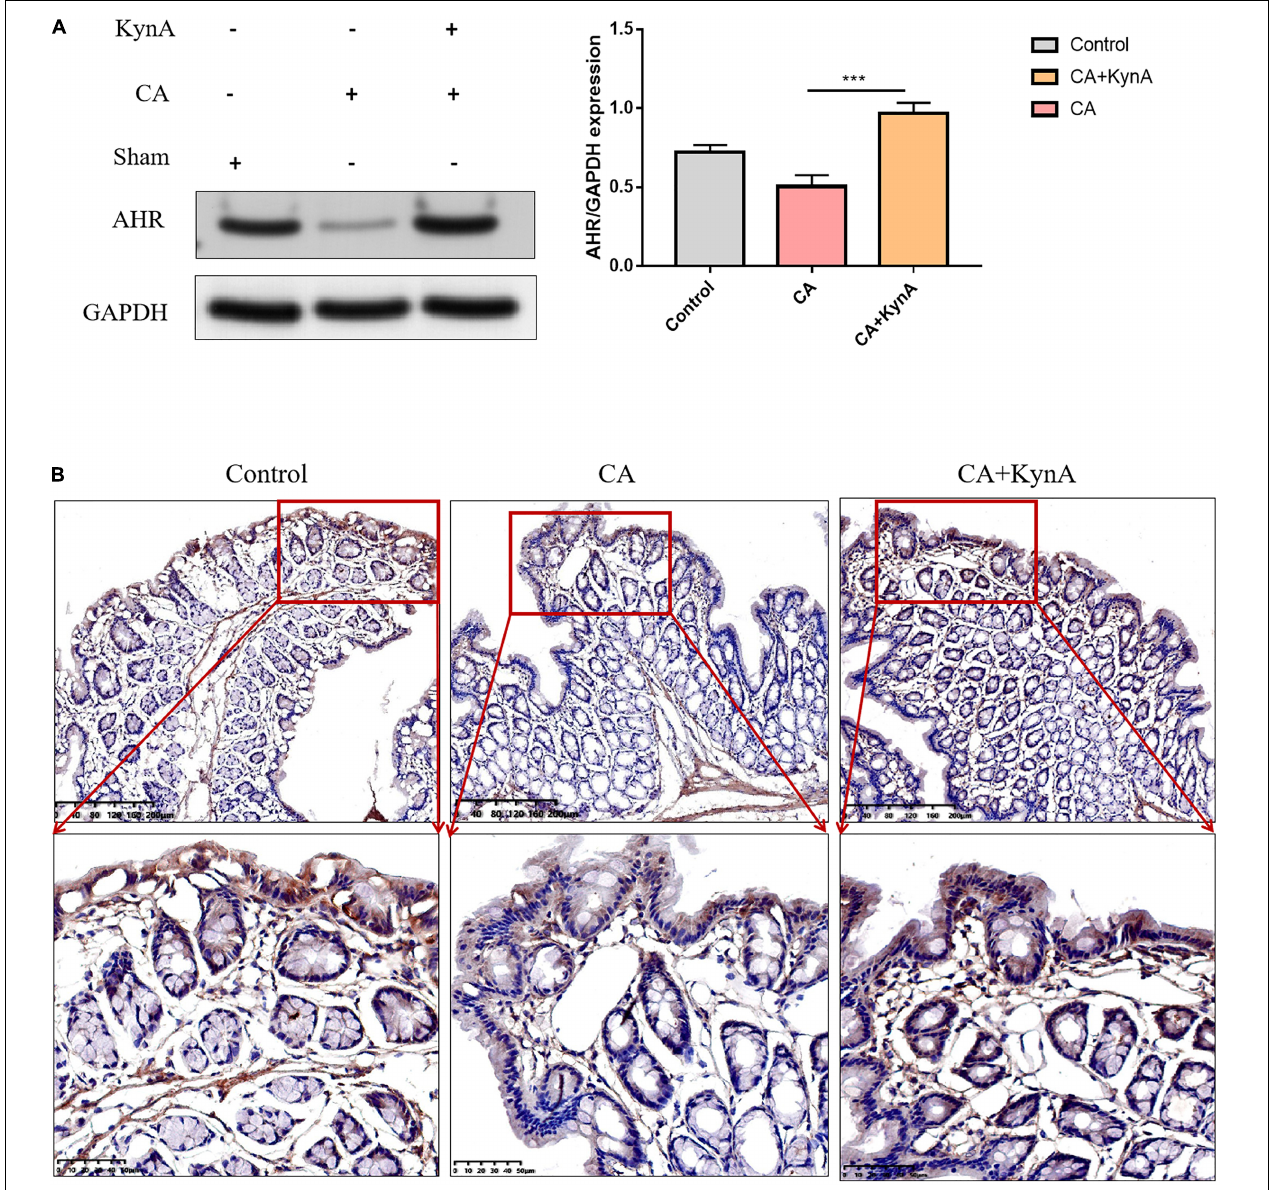
FIGURE 5 | Kynurenic acid activates AHR expression in the intestinal epithelium. (A,B) Western blot analysis and immunohistochemistry show higher expression of AHR in the CA+KynA group than in the CA group. Statistical significance was evaluated using the Mann–Whitney U test. P -values < 0.05 (*) or < 0.01 (**) were considered statistically significant. CA, Candida albicans infection; KynA, Kynurenic